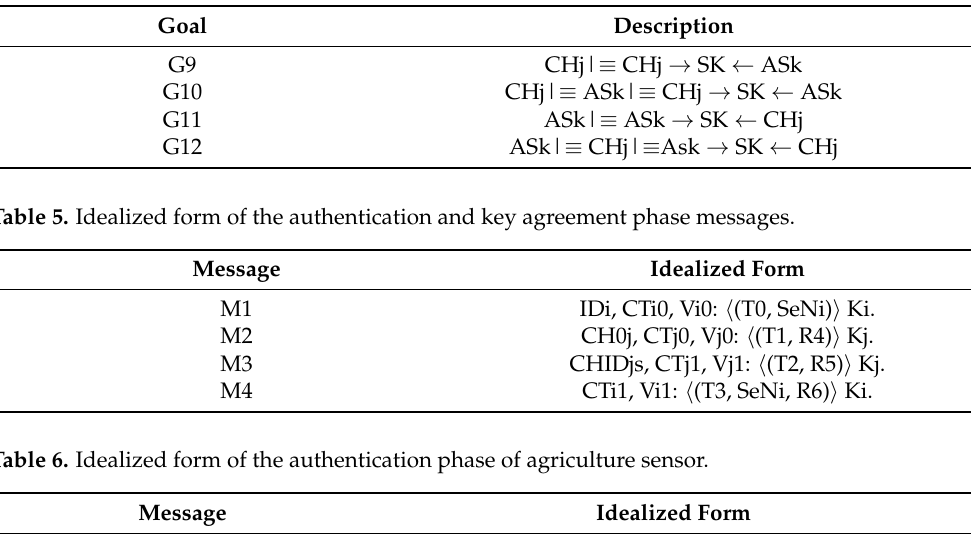
Table 4. Goals of the authentication phase of agriculture sensor.